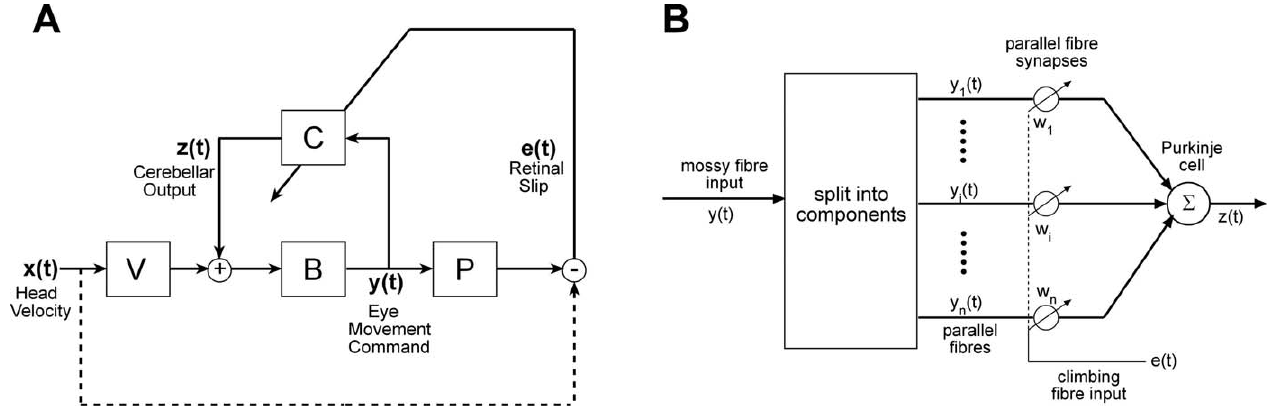
Figure 2. Linearised Model of Horizontal Vestibulo-Ocular Reflex, Derived from the Neural Circuitry Illustrated in Figure 1 (A) Head velocity x ( t ) is processed by the filter V , then added to the output z ( t ) of the adaptive filter C (which corresponds to the floccular region of cerebellum). The summed signal is then passed to the brainstem controller B . The output of B is a motor command y ( t ), which acts on the plant P . A copy of y ( t ) is sent back to the adaptive filter C . The command y ( t ) acts on P to move the eyes, a movement which is added to the head velocity x ( t ): net image movement is detected as retinal slip e ( t ) and sent to C . (B) Structure of the adaptive filter shown as C in (A). The copy of the eye-movement command y ( t ) arrives as mossy fiber input, and is decomposed into components y 1 ( t ) .... y n ( t ) by the granule cell layer. Each output component y i ( t ) is weighted by w i , corresponding to the efficacy of the corresponding synapse between a parallel fiber and the Purkinje cell. The weighted components are summed by the Purkinje cell and constitute the filter output. The value of each weight w i is adjusted according to the current value of the correlation between its component y i ( t ) and the global retinal slip signal e ( t ), which arrives as climbing fiber